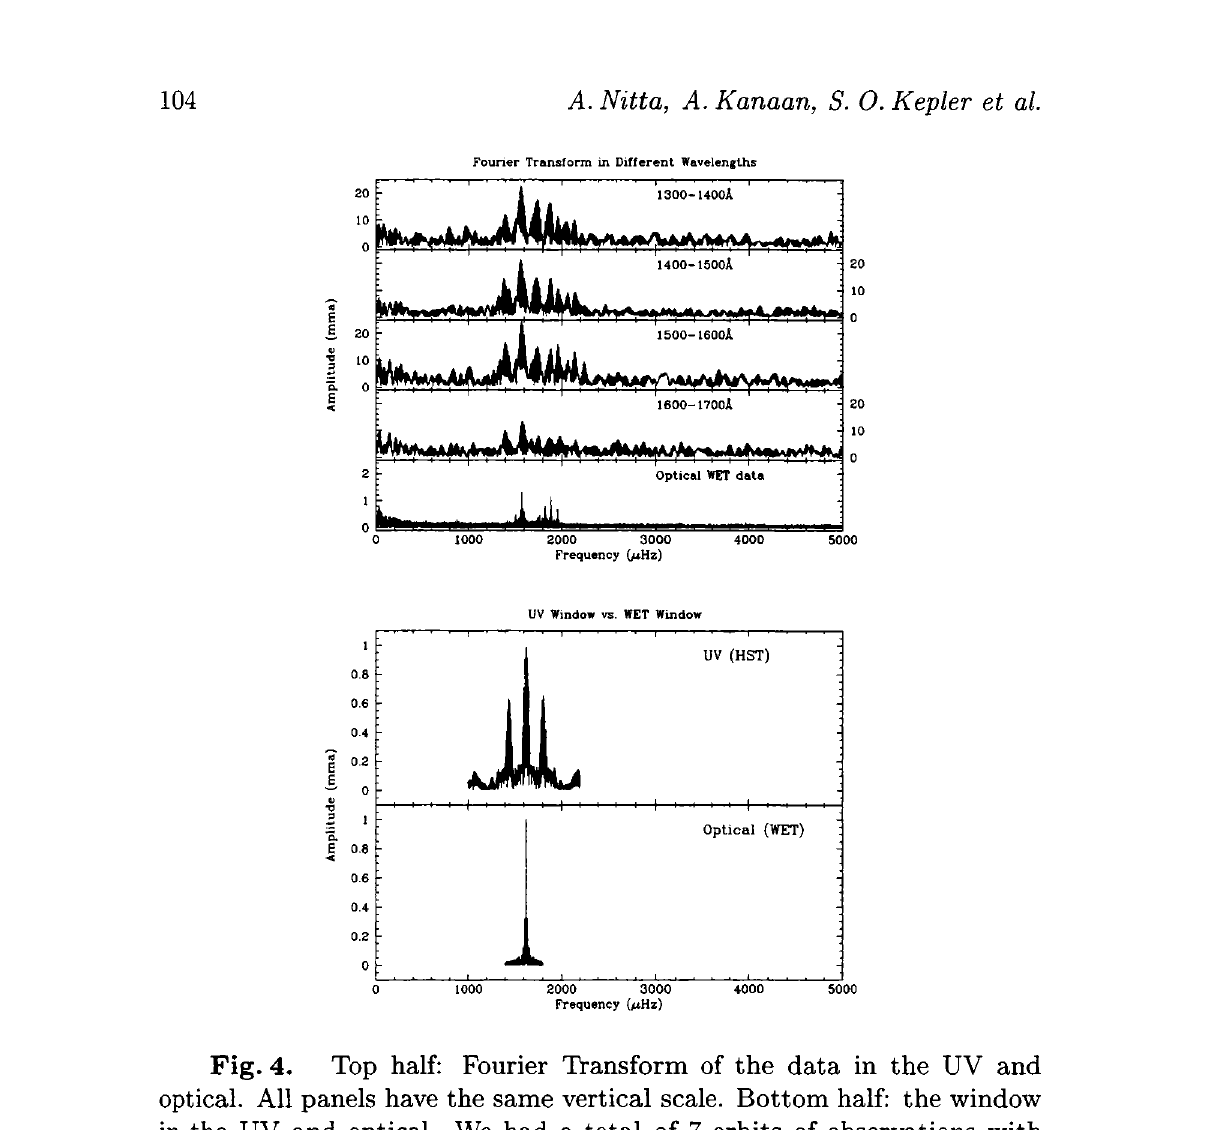
Fig. 4. Top half: Fourier Transform of the data in the UV and optical. All panels have the same vertical scale. Bottom half: the window in the UV and optical. We had a total of 7 orbits of observations with the HST. Due to the low orbit of HST, we can observe BPM 37093 only half of the time during each orbit. The WET window shows how superb a job we can do in determining the periods of the modes in the optical, compared to the HST